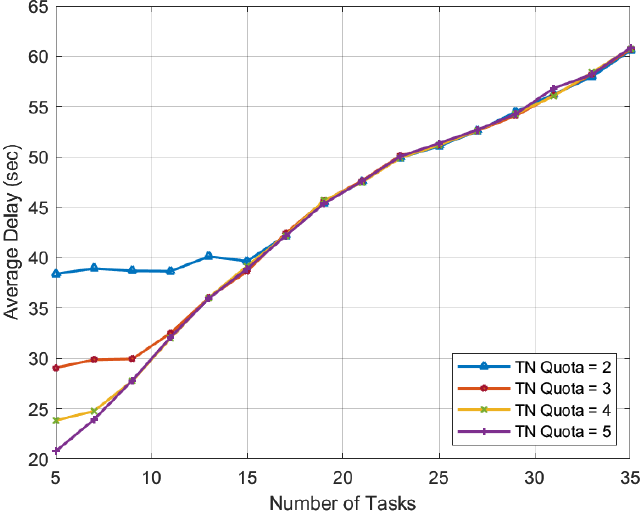
Figure 7. Average task latency with a varying quota of TN